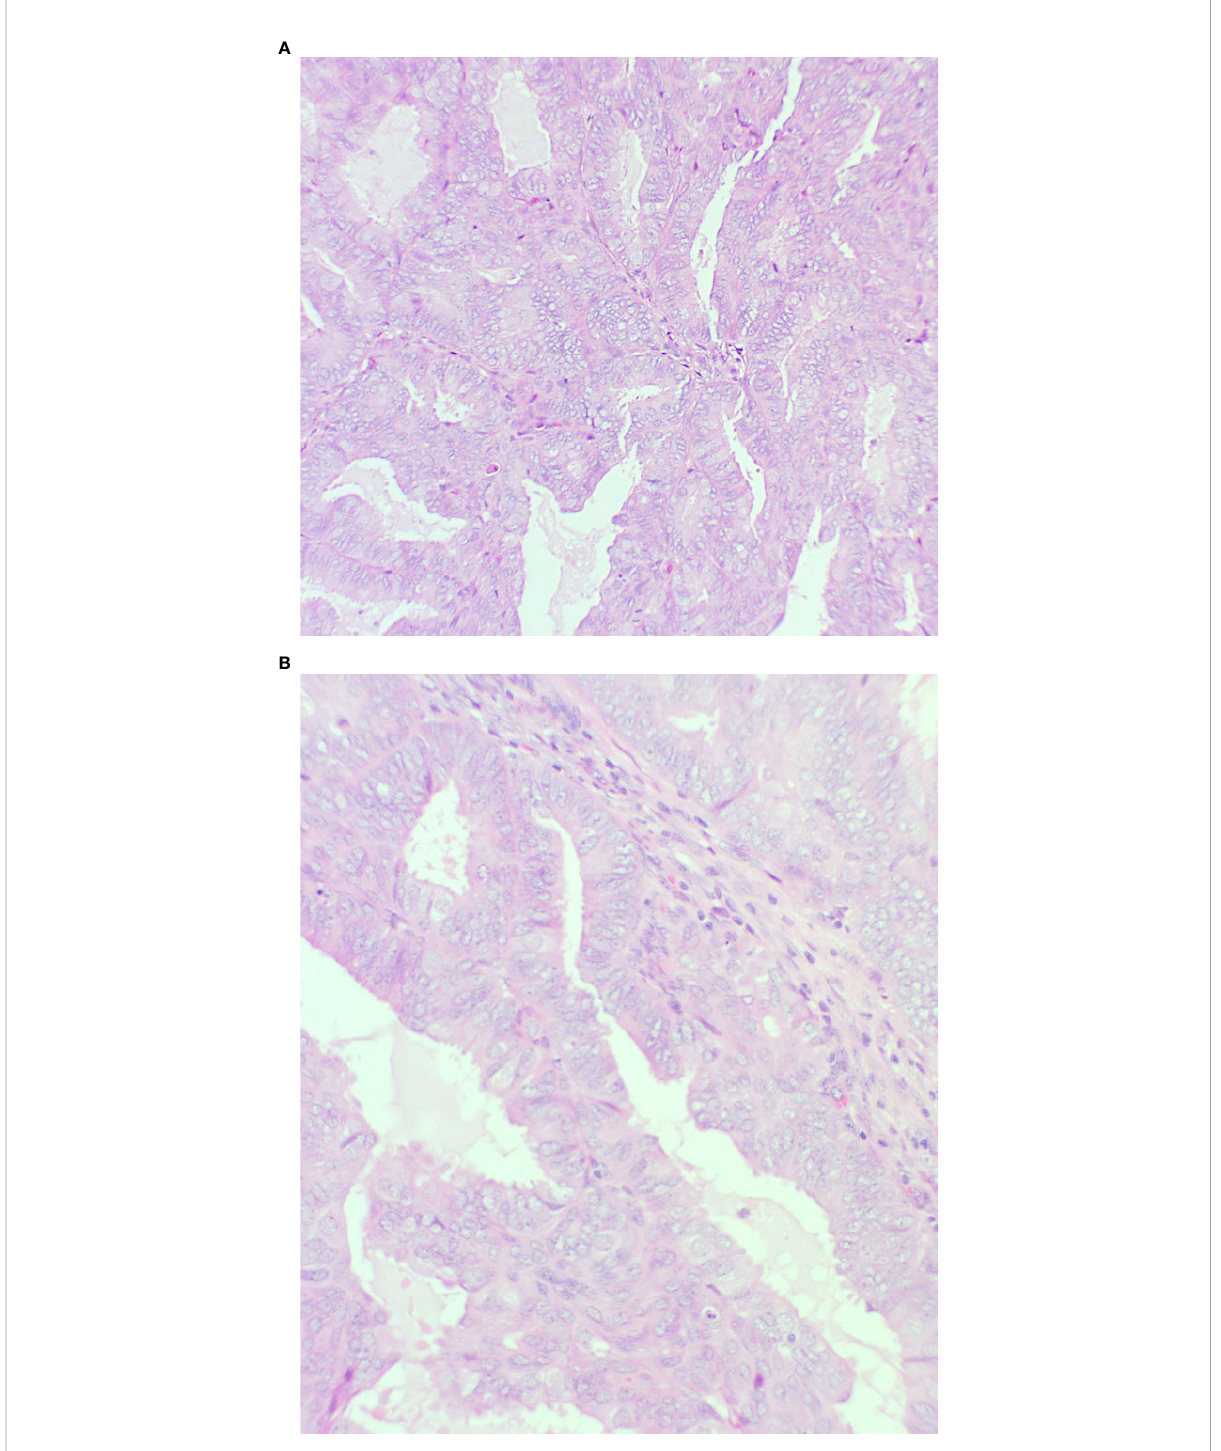
FIGURE 2 Endometrium showing features of an endometrioid endometrial carcinoma (A) : x20 magni fi cation and (B) : x40 magni fi cation. There is a glandular proliferation with no intervening stroma composed of cells with pseudostrati fi ed nuclei. Mild nuclear atypia is present consistent with grade